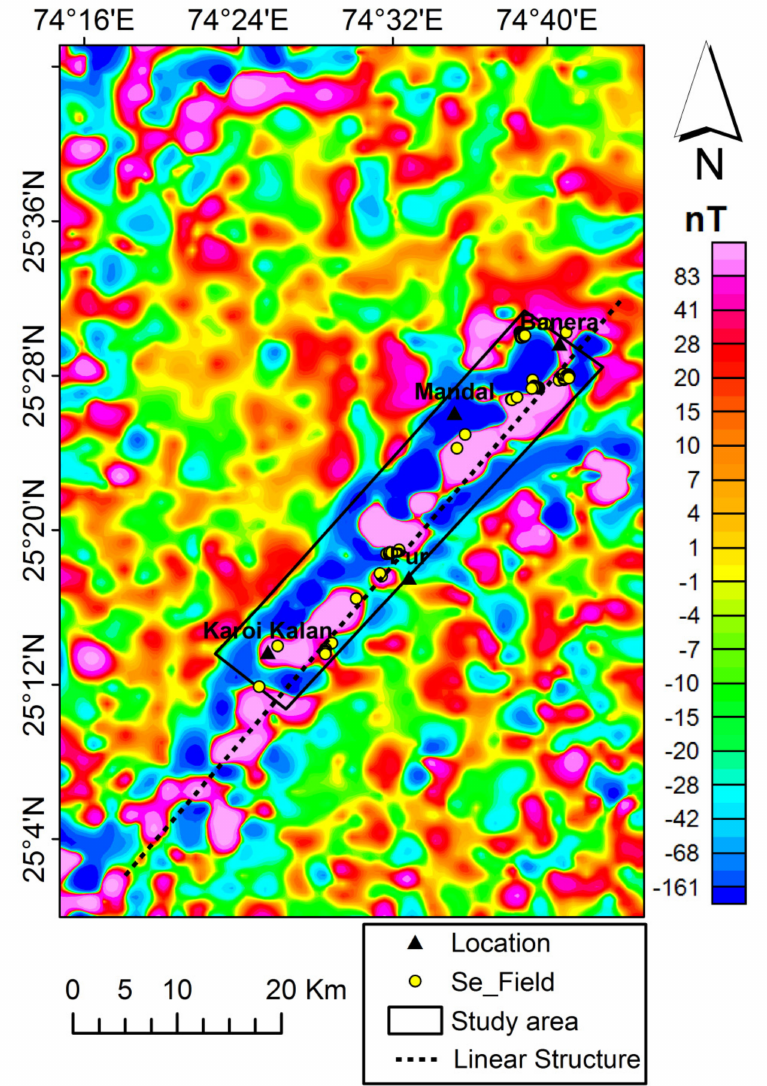
Figure 19. Residual magnetic anomaly map inferring linear structures along the field validated areas with the presence of surface proxies of mineralization (either the presence of Gossan or alteration